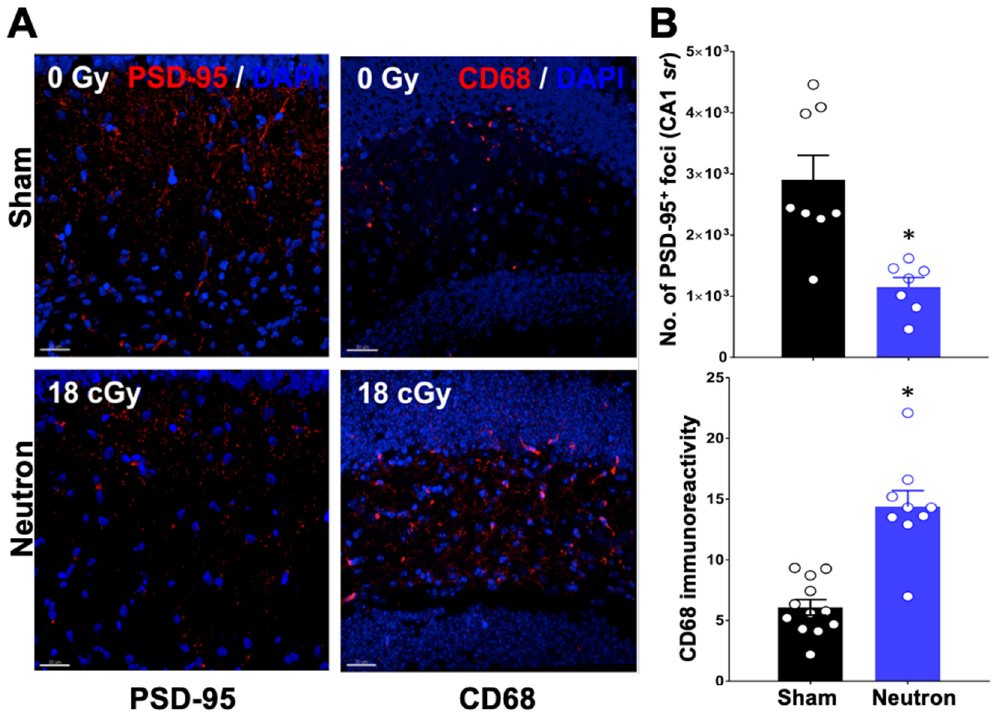
Figure 2. PSD-95 decreases while CD68 immunofluorescence staining increases in the dentate gyrus region of the mouse brain after three and a half months following neutron irradiation. ( A ) Representative staining of PSD-95 (red) in sham (0 Gy) counterstained with DAPI in blue is shown in the top left panel while the bottom right panel shows PSD-95 and DAPI in neutron irradiated brain region (18 Gy). CD-68 (red) in sham (0 Gy) is shown in the top right panel while the bottom right panel shows a representative staining in the neutron-irradiated brain region. ( B ) Volumetric quantification of PSD-95 + puncta (left panel) demonstrate significant reductions in molecular layer PSD-95 of the neutron-irradiated brain while quantitative analysis of CD68 + cells (right panel) demonstrates that compared to controls, irradiated mice exhibit increased microglial activation. Data presented as mean ± SEM where n = 2 tissues from each of 4 mice/group. p values derived from unpaired Student’s t tests. * p < 0.05. Scale bar = 30